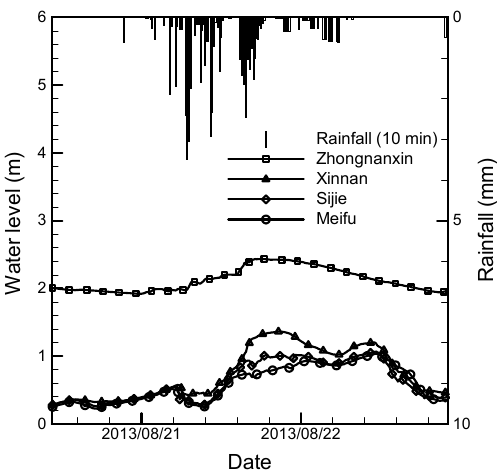
Figure 2. Rainfall and water-level data recorded by SNTIX during typhoon